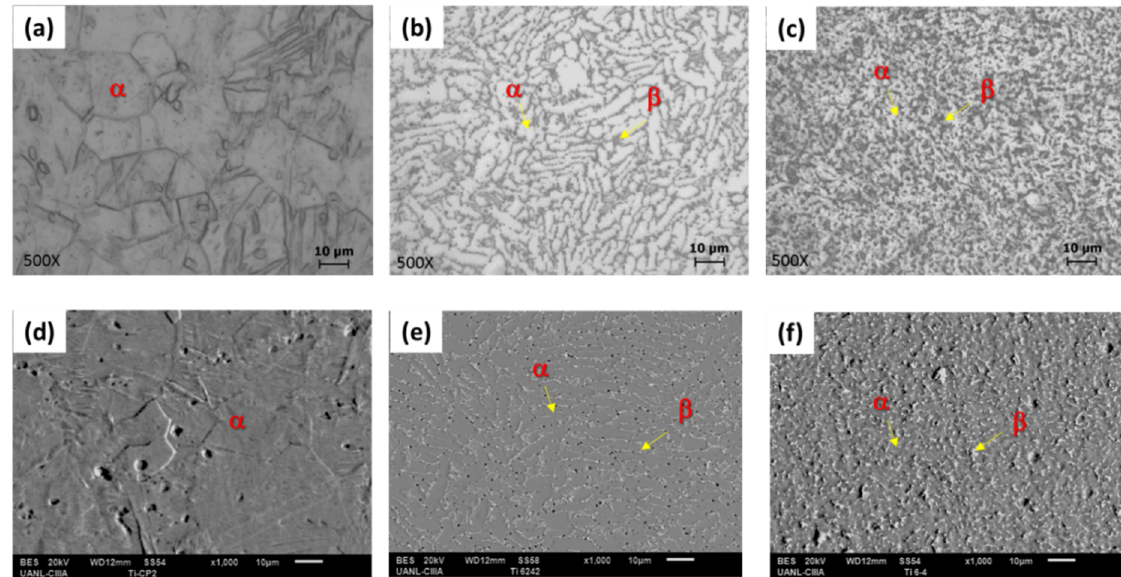
Figure 1. OM and SEM micrographs of titanium alloys (initial conditions): ( a , d ) CP2, ( b , e ) Ti-6Al-2Sn-4Zr-2Mo, ( c , f ) Ti-6Al-4V.